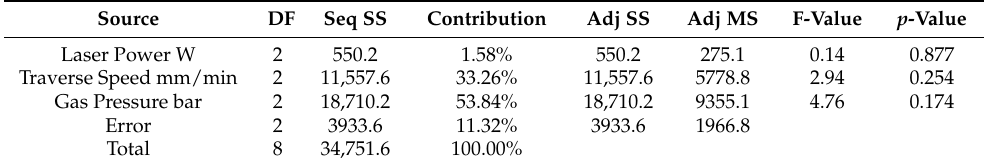
Figure 5. S / N ratio smaller-is-better average value of input cutting parameters of 6 mm thick SPF-UPE. Table 11. ANOVA table for HAZ response of input cutting parameters of 6 mm thick SPF-UPE.